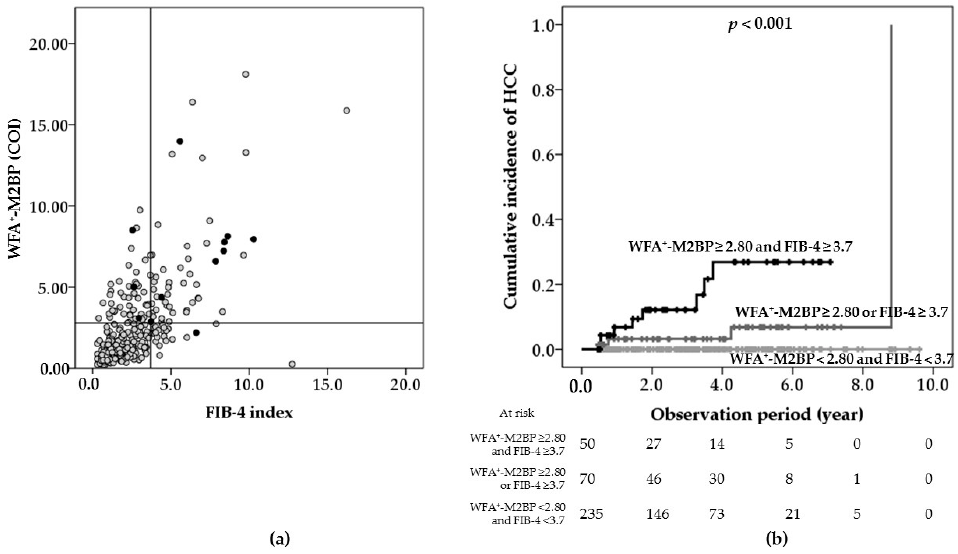
Figure 4. ( a ) Relationship between serum Wisteria floribunda agglutinin-positive Mac-2-binding protein (WFA + -M2BP) levels and Fibrosis-4 (FIB-4) index. Black and gray circles represent patients with and without HCC development, respectively. Vertical and horizontal line represent FIB-4 index = 3.7 and WFA + -M2BP = 2.80 COI, respectively; ( b ) Cumulative incidence of hepatocellular carcinoma (HCC) development after sustained virologic response, shown according to serum WFA + -M2BP level and FIB-4 index.